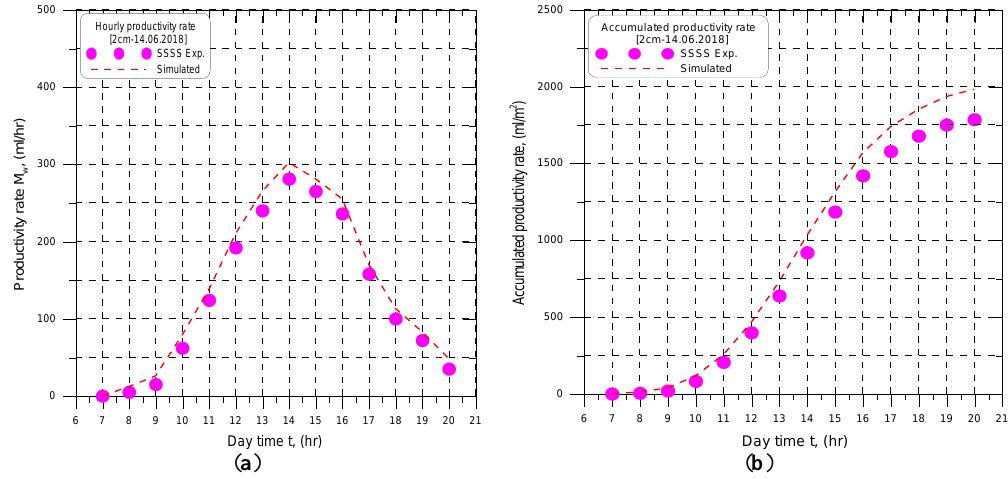
Figure 13. A comparison between the simulated and experimental results of hourly and accumulated productivities for the studied still with a water depth of 2 cm . ( a ) hourly productivities ( b ) accumulated productivities.